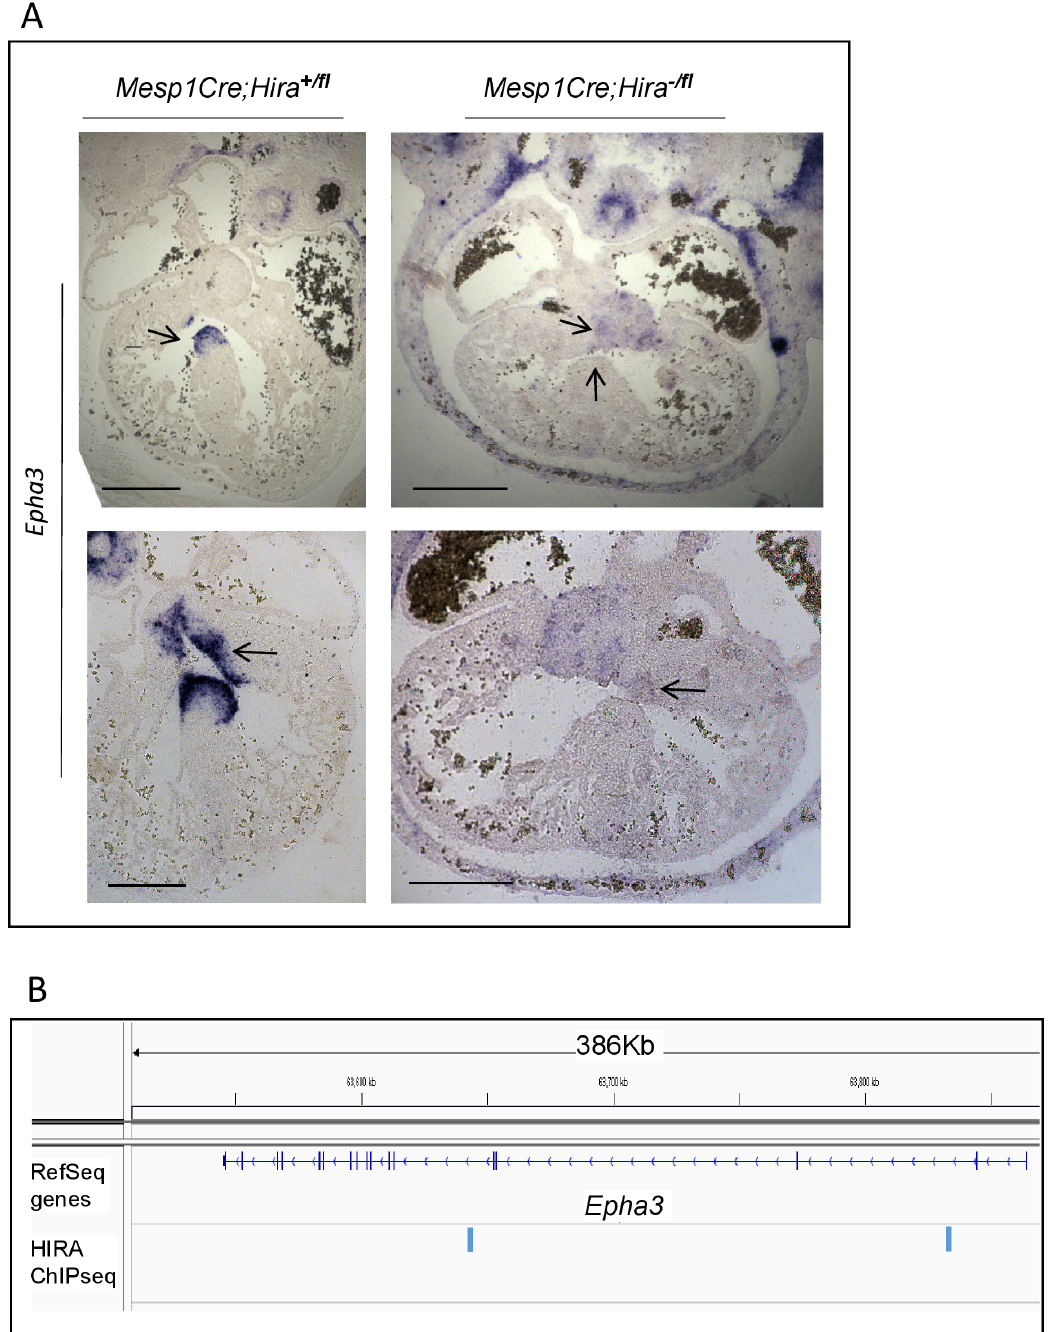
Fig 4. Epha3 is downregulated when HIRA is conditionally deleted, and HIRA binds to the gene body of Epha3 . A . In situ hybridization of Epha3 on transverse sections of E12.5 embryonic hearts with the indicated genotypes (n = 2). Hira -conditional mutant hearts displayed low expression of Epha3 in both the membranous portion of the septum (upper panels) and the endocardial cushions (lower panels) compared to littermate controls as indicated by a black arrow. Scale bar : 100 μ m B. IGV profile showing two HIRA enriched loci in intronic regions of Epha3